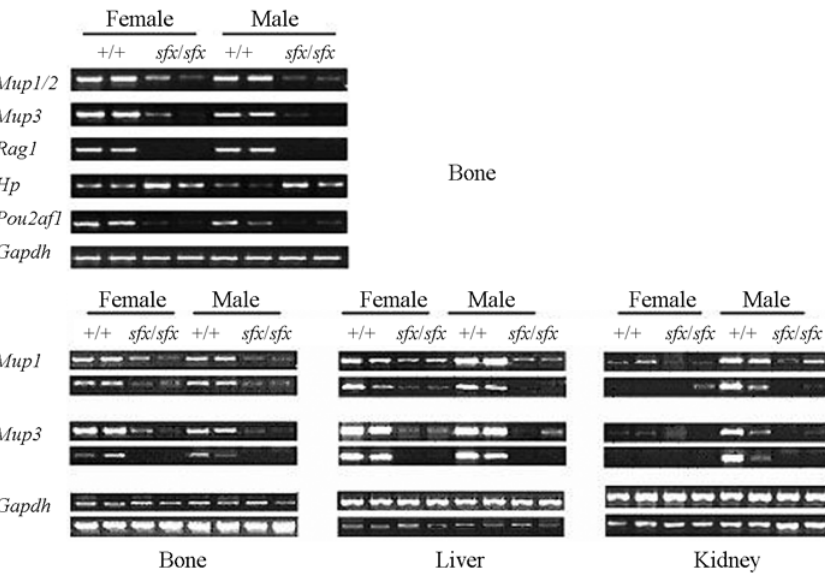
Figure 3 - Validation of microarray data using semi-quantitative RT-PCR. Five genes with different expression patterns across femur, liver and kidney, identifiedbymicroarrayanalysis,wereselectedforvalidatingthemicroarrayassayused,bysemi-quantitativeRT-PCR.Insteadofusingpooledsamples, asinthemicroarrayanalysis,individualage-matchedsampleswereusedfortheconfirmation.Thedownregulationof Mup1/2,Mup3,Rag1, and Pou2af1 mRNAs, as well as the upregulation of Hp in the bone, were well validated in the sfx mice (A, B). In addition, the gender specificity of Mup genes was identified, mainly in the wild-type murine kidney